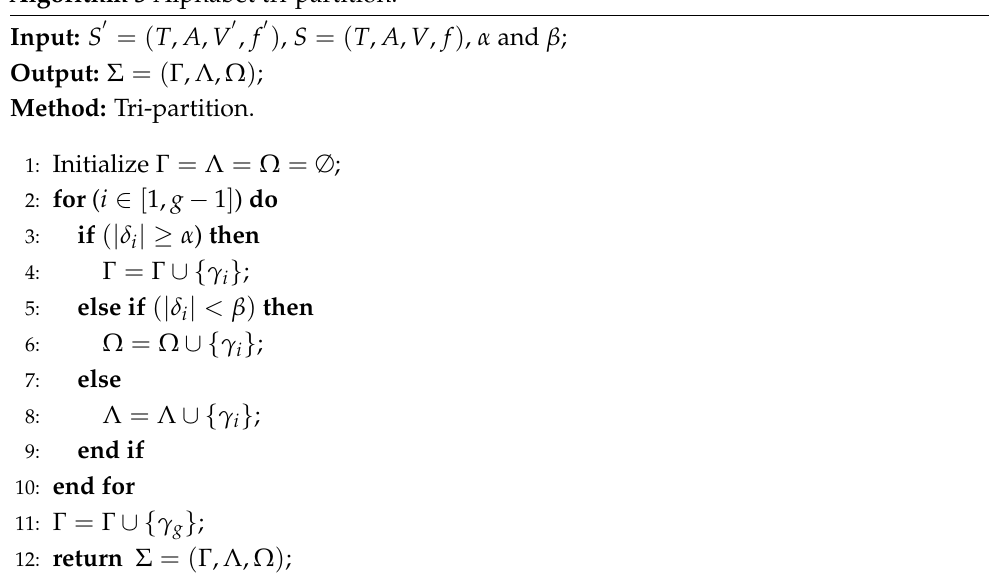
Algorithm 3 Alphabet